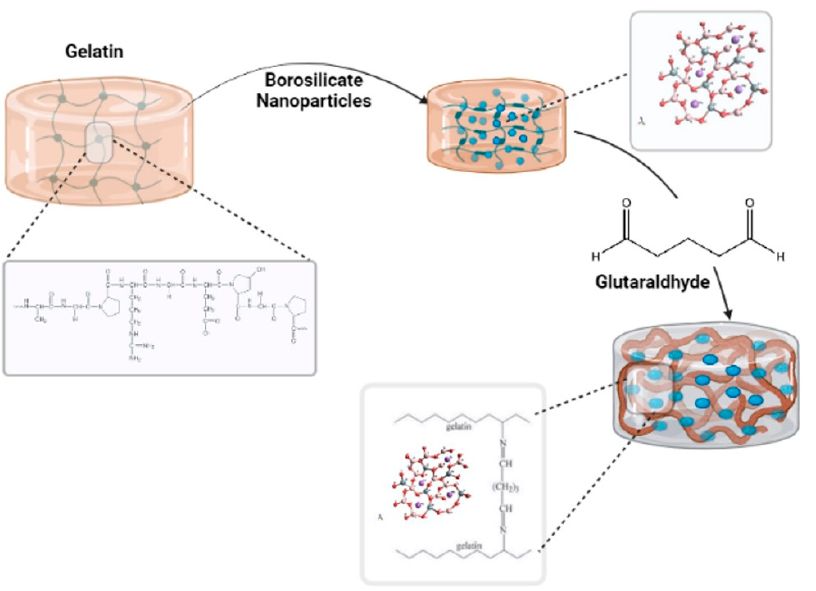
Figure 3. Schematic study of the cross-linking mechanism of gelatin/borosilicate/glutaraldehyde nanocomposite hydrogels.